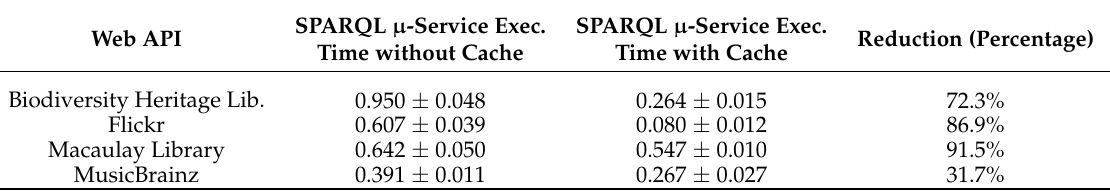
Table 2. Query execution time (in seconds) against a SPARQL micro-service without/with cache. The last column is the percentage of time reduction obtained when using the